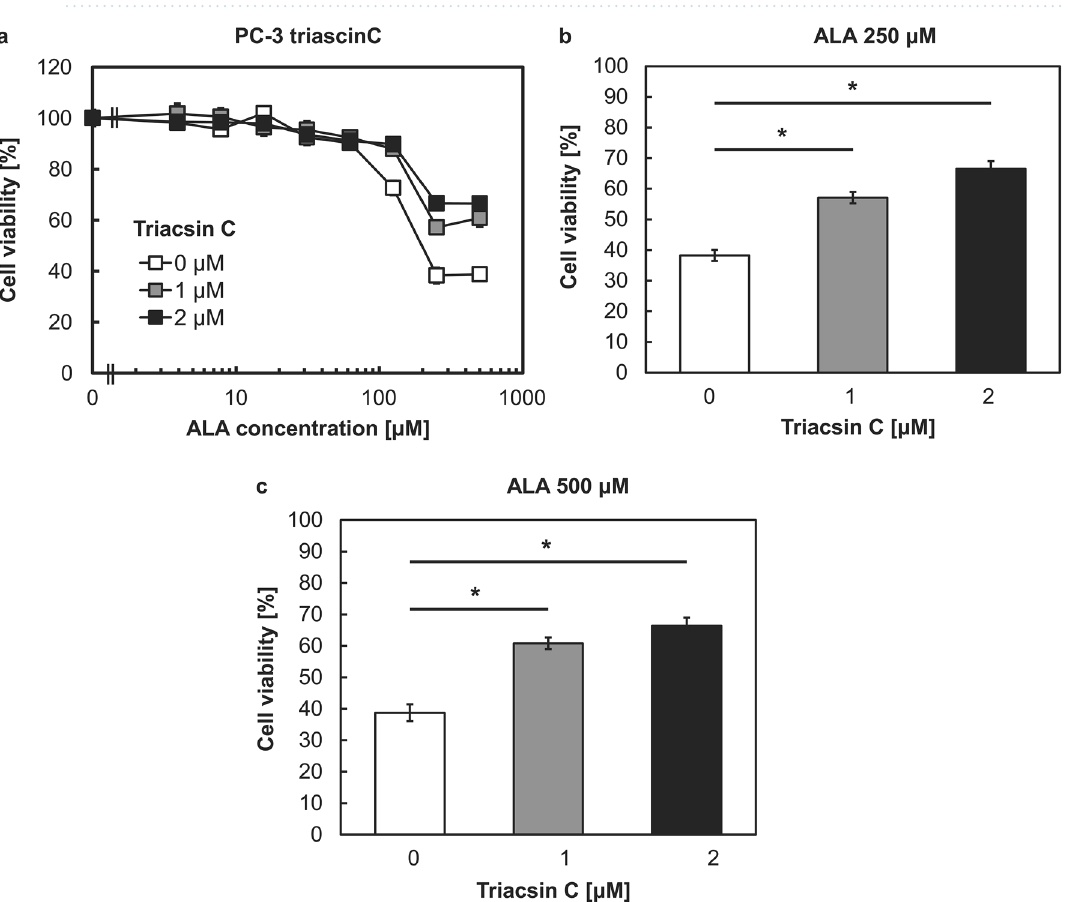
Figure 6. Cell viability after 5-aminolevulinic acid-based photodynamic therapy (ALA-PDT) with or without triacsin C. Cells were treated with triacsin C alone for 48 h and then co-cultured with triacsin C and ALA for 24 h. Cells were irradiated with 14.2 mW/cm 2 light for 5 min. Cell viability was determined on the next day using the MTT assay. ( a ) Cell viability in the presence of 0–2 μM Triacsin C and various ALA concentrations. ( b ) Cell viability in the presence of 250 μM ALA. ( c ) Cell viability in the presence of 500 μM ALA. n = 8. * p < 0.001. All bars represent the